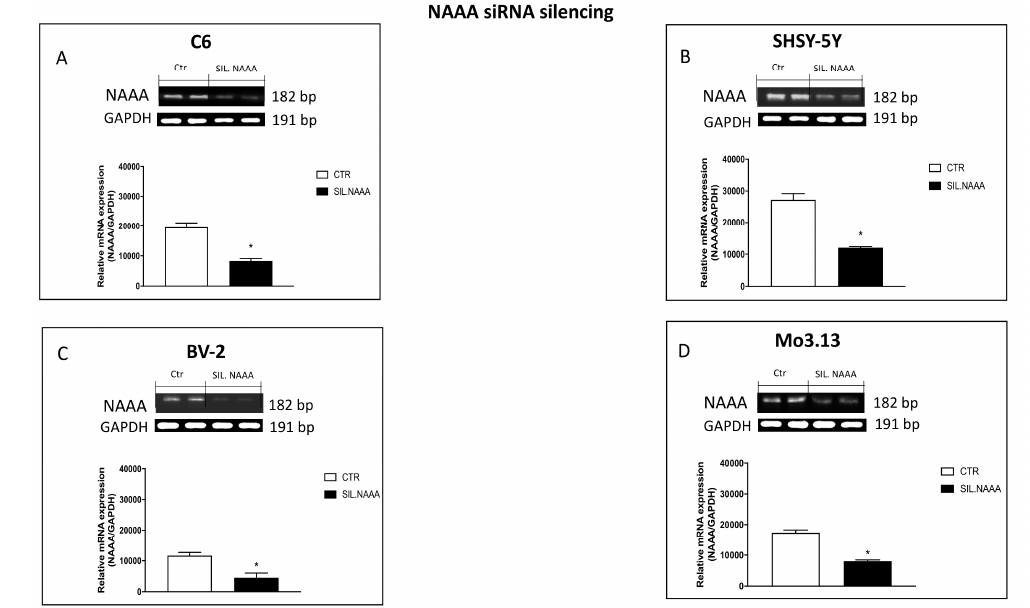
Figure 3. Evaluation of N -acylethanolamine acid amidase (NAAA) expression following NAAA small interfering RNA (siRNA) knockdown. NAAA mRNA expression was determined in C6, SHSY-5Y, BV-2, and Mo3.13 cells, that were either transfected for 48 h with NAAA-specific siRNA. Values are normalized to GAPDH and expressed as fold change to untreated control cells ( A – D ). The silencing efficiency was achieved in all cell lines studied ( A – D ). Data are representative of at least three independent experiments. ( A ) * p < 0.05 versus CTR; ( B ) * p < 0.05 versus CTR; ( C ) * p < 0.05 versus CTR; ( D ) * p < 0.05 versus CTR.